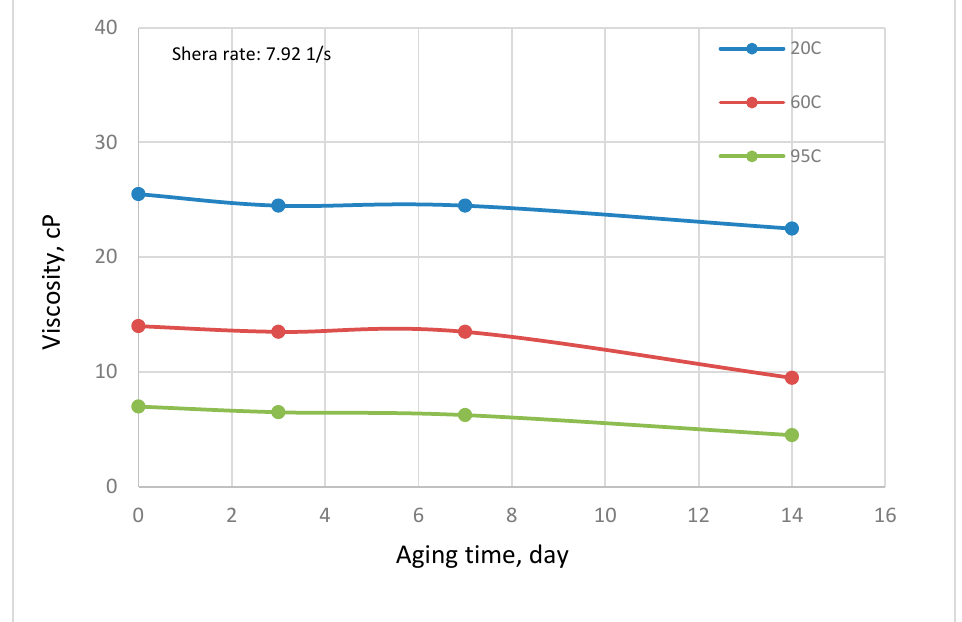
Figure 7. Effect of aging time on the rheological behavior of OM in seawater salinity (temperature = 20, 60, and 95 °C; shear rate = 7.92 s − 1 ).